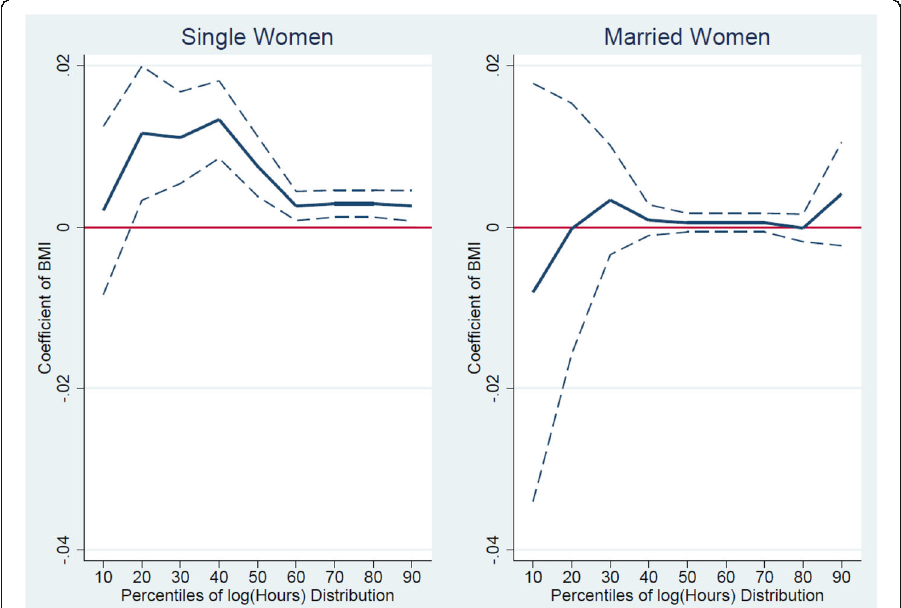
Fig. 3 BMI and log hours of work for Black women : Unconditional Quantile regression estimates (with 95% confidence interval). Note: Control variables include work experience (quadratic), educational categories, dummies for whether the woman believes in traditional gender roles, whether the respondent has any children, if the youngest child is below six, yearly age dummies, region of residence dummies, and year dummies. For the married sample, additional controls include spouse ’ s age, educational categories, and annual income